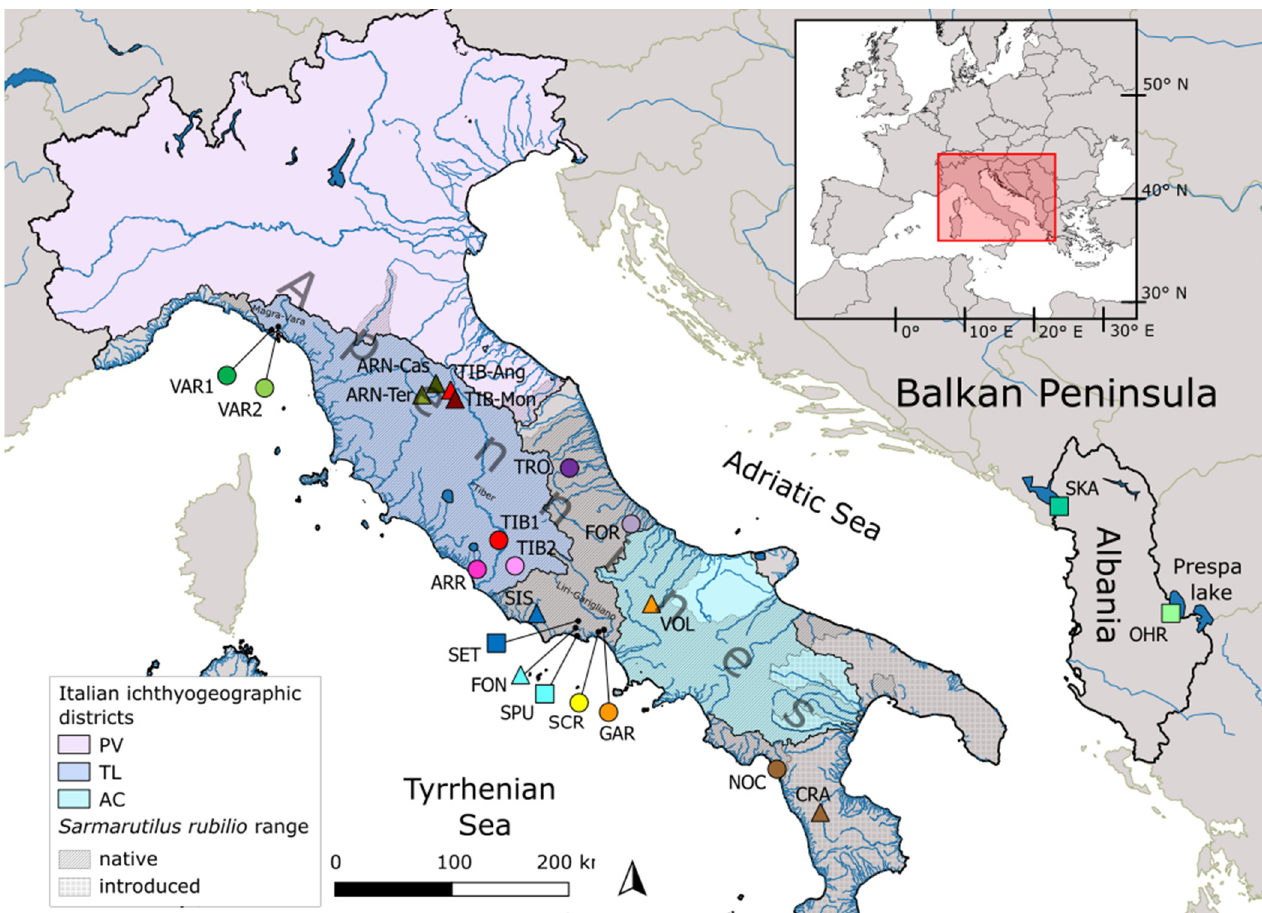
Figure 1. Geographic location of the study area (black and red rectangles, top right), along with S. rubilio distribution according to IUCN (https://www.iucnredlist.org/species/19786/9014268, accessed on 11 April 2022), and sampling sites: circle indicates rivers and square lakes. For abbreviations refer to Table 1. Triangles indicate sites corresponding to sequences retrieved from the Genbank database and included in the COI phylogenetic reconstruction. Names of major basins discussed in the paper are also indicated.